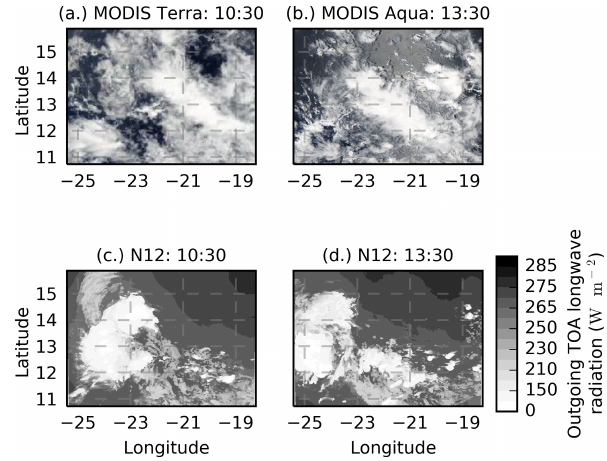
Figure 3. Cloud field evolution. MODIS Terra (a) and Aqua (b) Corrected Reflectance images of the modelled domain for 21 Au- gust 2015 and the corresponding simulated top-of-atmosphere out- going longwave radiation for the N12 simulation (c, d) . Note that the colour bar relates to panels (c) and (d) only. Images shown in panels (a) and (b) are Moderate Resolution Imaging Spectrora- diometer (MODIS) Corrected Reflectance imagery produced using the MODIS Level 1B data and downloaded from the NASA World- view